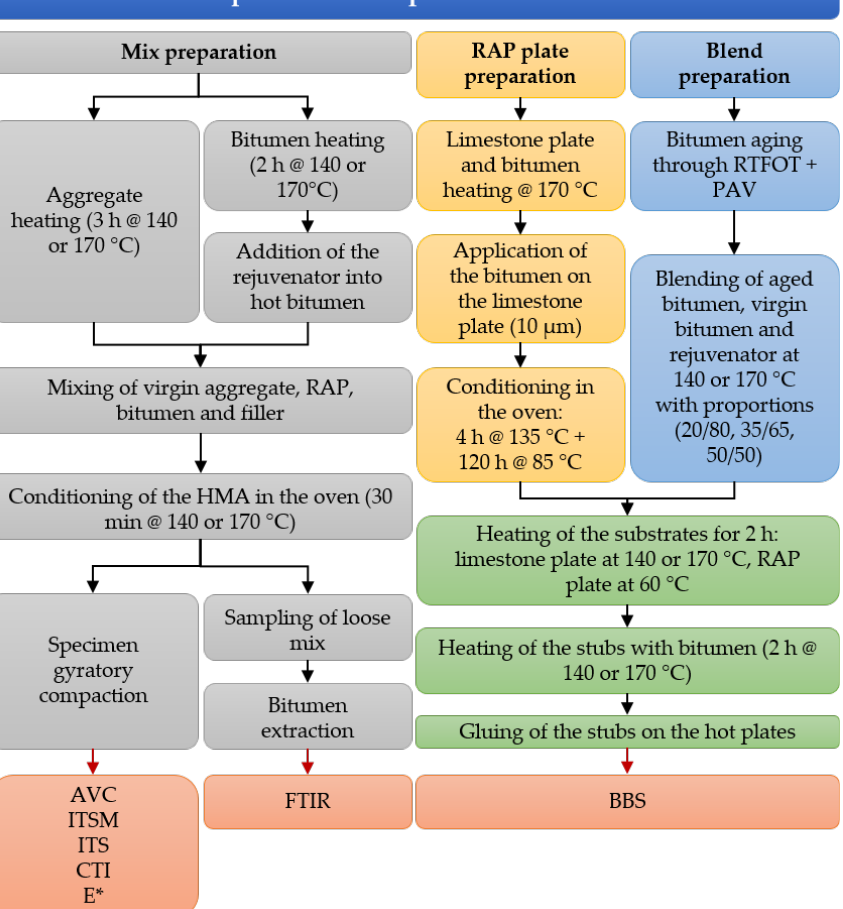
Figure 2. Experimental program and specimen preparation. (The code “E*” indicates the norm of the complex modulus).